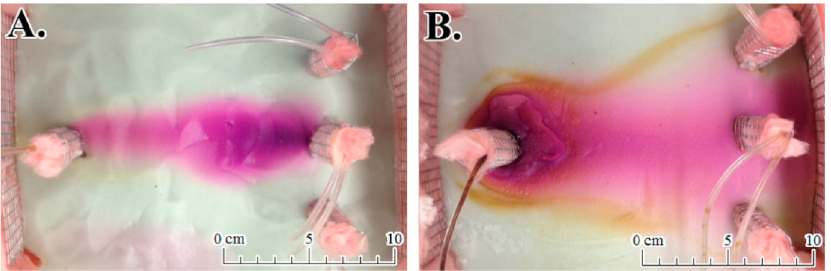
Figure 5. Optical data from flow tank tests of ( A ) a 26 g/L KMnO 4 solution 9 h after injection and ( B ) a B-40 SRPG solution 73 h after injection in all-porous media.